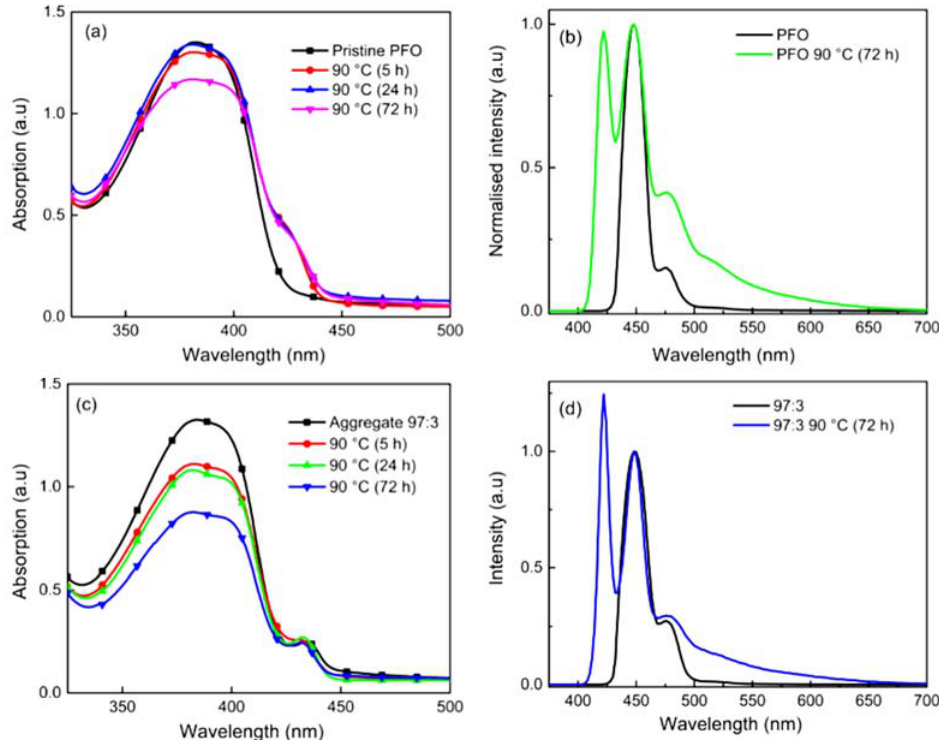
Figure 4. UV-Vis absorption spectra of ( a ) pristine PFO film and ( c ) 97:3 aggregated PFO film, and PL intensity spectra of ( b ) pristine PFO film and ( d ) 97:3 aggregated PFO film, before and after thermal degradation test.